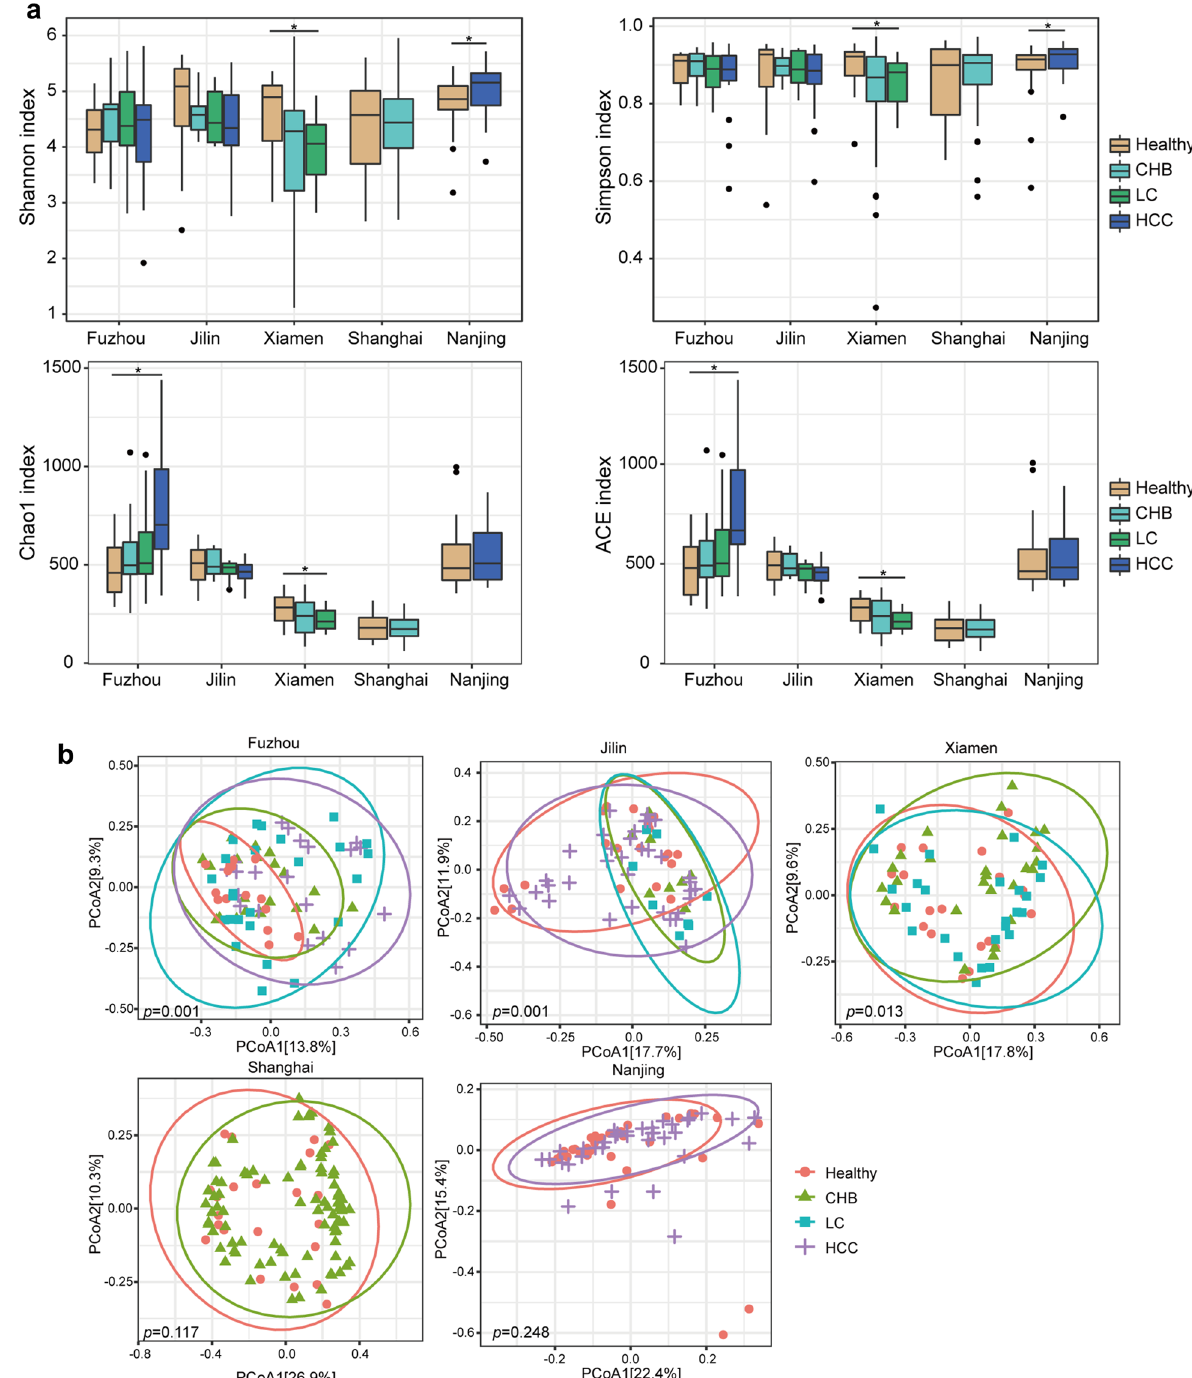
Fig. 1 Microbial diversity differences between different groups. a Alpha diversity measured by the Shannon index, Simpson index, Chao1 index and ACE index. *: p < 0.05. b PCoA of beta diversity based on Bray–Curtis distance for five